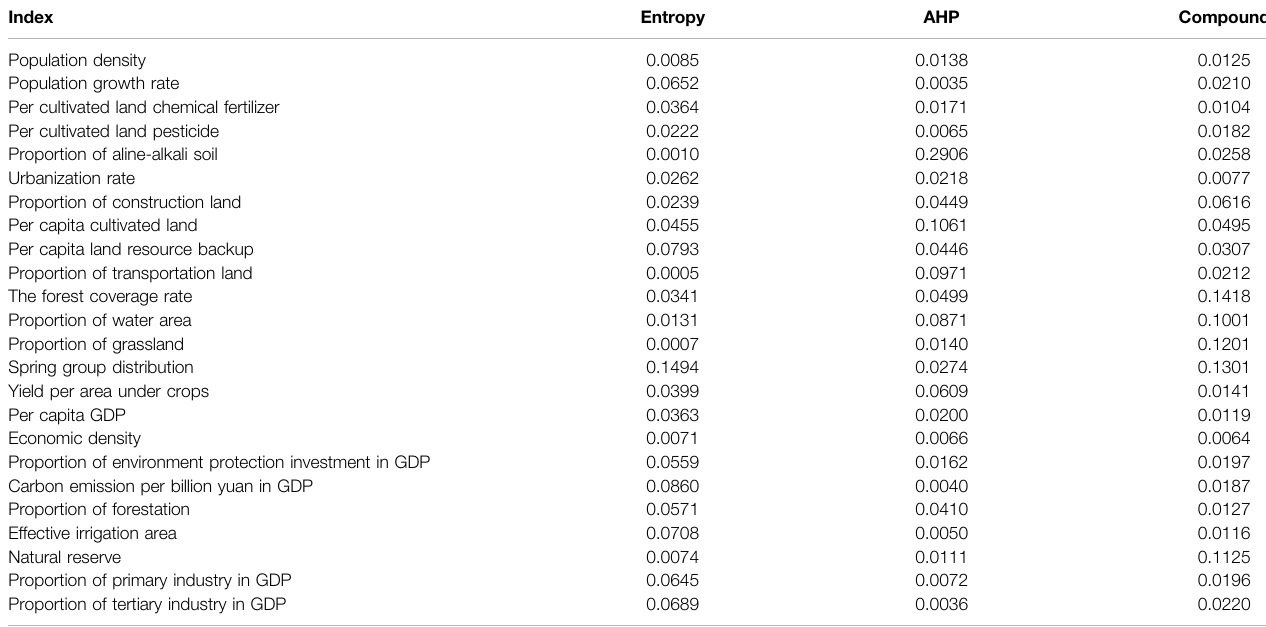
TABLE 2 | Land ecological security assessment weights in Jinan.